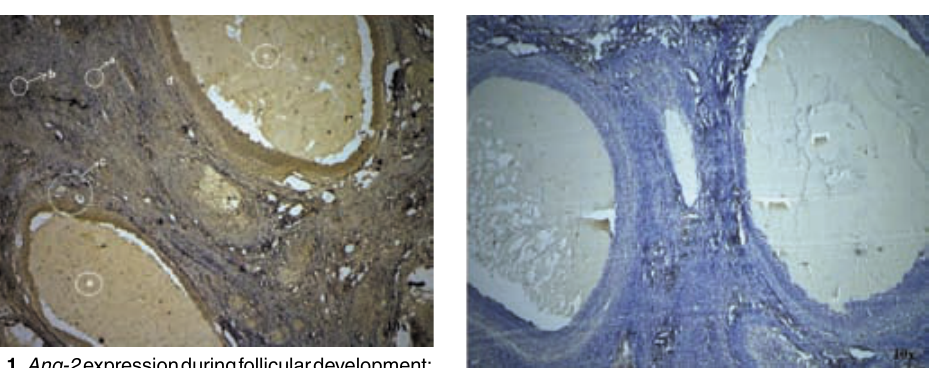
Fig.1 Ang-2 expression during follicular development: (a) primordial follicles (b) primary follicles, (c) small antral follicle, (d) large antral follicle (e) follicular fluid in antral follicle